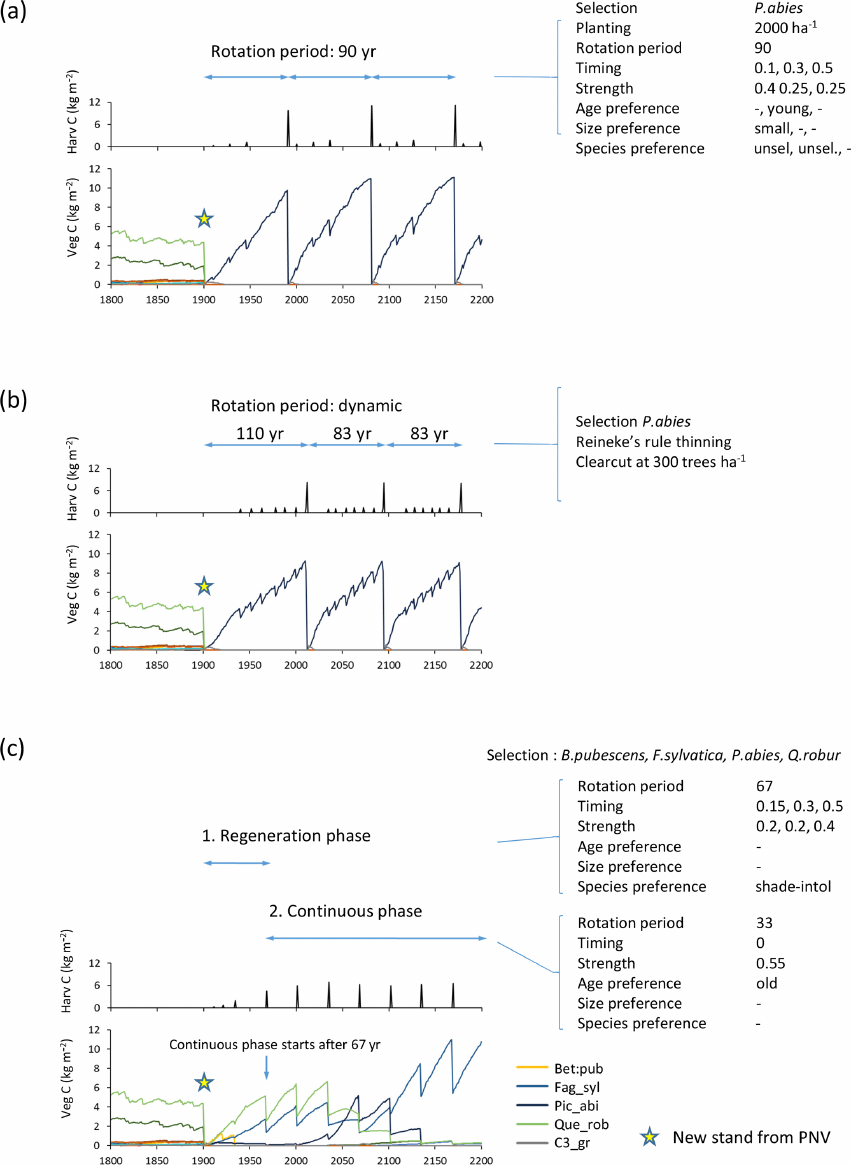
Figure 5. Examples of forest management settings. Forestry stands were created from clear-cutting of PNV in 1901. (a) Detailed clear-cut forestry: spruce monoculture with fixed rotation period and thinning parameters. (b) Automated clear-cut forestry: spruce monoculture with automated thinning and clear-cutting. (c) Continuous selection/shelterwood cutting: species selection, B. pubescens, F. sylvatica, P. abies, Q. robur , established after clear-cutting. Later reestablishment of all species allowed. Cutting of shade-intolerant species during a regeneration phase. Continuous partial harvest of old trees every 33 years allows establishment of young cohorts while suppressing shade-intolerant species. Species/PFT abbreviations are as follows: Bet_pen, Betula pendula ; Fag_syl, Fagus sylvatica ; Pic_abi, Picea abies ; Que_ rob, Quercus robur ; and C3_gr, C 3 grass. Location, climate input, and species in PNV are as in Fig.